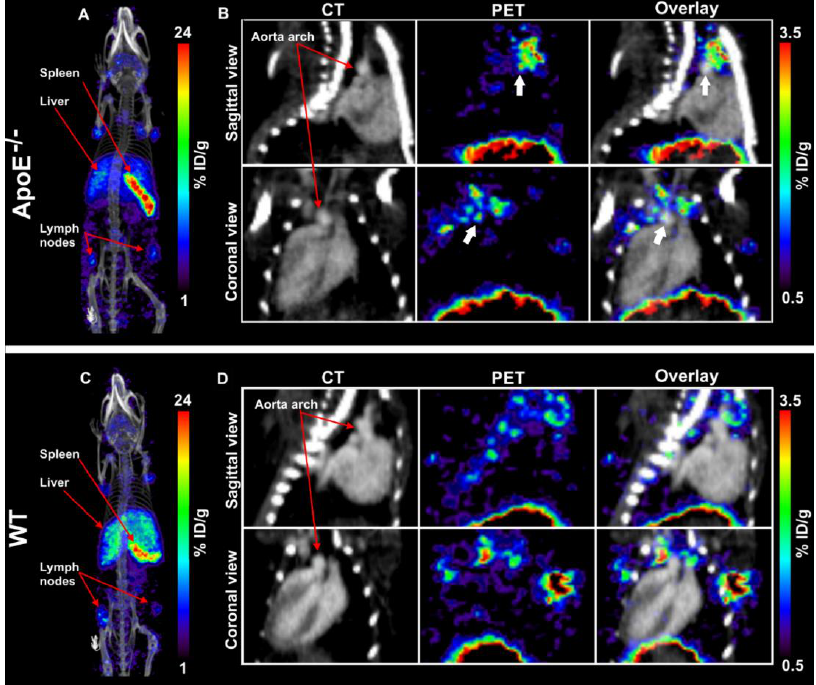
Figure 2. Representative PET/CT image of a ApoE −/− and WT mouse 7 days after administration of [ 89 Zr]Zr-anti-CD40 mAb. ( A , C ) MIP images of ApoE −/− and WT mouse. ( B , D ) Tracer distribution in aorta of ApoE −/− and WT mouse: CT image ( left ), aortic arch indicated by red arrows, PET image ( middle ), and CT image overlayed with PET ( right ). White arrows indicate apparent uptake in plaques. Data is expressed in percent injected dose per gram tissue (%ID/g). High expression of CD40 in healthy organs might induce a sink effect that alters the antibody kinetics and atherosclerotic plaque targeting. In certain cases, a saturation of the sink organs can improve targeting to the organs of interest [22]. To investigate this, we evaluated the effect of a higher mass dose (“high dose” of 1000 μg) on the pharmacoki- netics and aorta uptake of [ 89 Zr]Zr-anti-CD40 mAb in ApoE −/− mice. Higher [ 89 Zr]Zr-anti- CD40 mAb uptake was observed in the aorta with the “high dose” compared to the “low dose” at day 3 and 7 p.i. (6.73 ± 0.65 %ID/g vs. 3.70 ± 0.50 %ID/g; 1.41 ± 0.56 %ID/g vs. 0.71 ± 0.13 %ID/g; p < 0.05, respectively). Additionally, signif- icantly higher [ 89 Zr]Zr-anti- CD40 mAb levels were observed in the blood with the “high dose” of antibody (day 3: 6.70 ± 1.35 %ID/g vs. 2.75 ± 0.40 %ID/g; day 7: 0.74 ± 0.40 %ID/g vs. 0.21 ± 0.02 %ID/g; “high and low dose”, respectively ) which indicate a CD40 sink effect. Aorta-to- blood ratios were significantly lower for the “high dose” compared to the “low dose” at day 3 (1.08 ± 0.07 vs . 1.37 ± 0.03, respectively) and day 7 (2.05 ± 0.47 vs. 3.34 ± 0.62, respectively) (Figure 3, Tables S1 and S2). Additionally, the aorta-to-blood ratio of the “high dose” in ApoE −/− mice was comparable to WT mice dosed with 100 μg mAb. This indicates that a high mass dose of [ 89 Zr]Zr-anti-CD40 mAb is not favorable for PET imag- ing of plaques due to the slower blood kinetics that leads to poor image contrast. In the CD40-rich organs, spleen, and lymph nodes, we observed lower uptake of [ 89 Zr]Zr-anti- CD40 mAb in the “high dose” compared to the “low dose” , indicating a blocking effect in these organs and demonstrating the specificity of the tracer for targeting CD40 in vivo. Similar levels of [ 89 Zr]Zr-anti-CD40 mAb uptake were observed in the liver for both doses (Figure 3G,H).